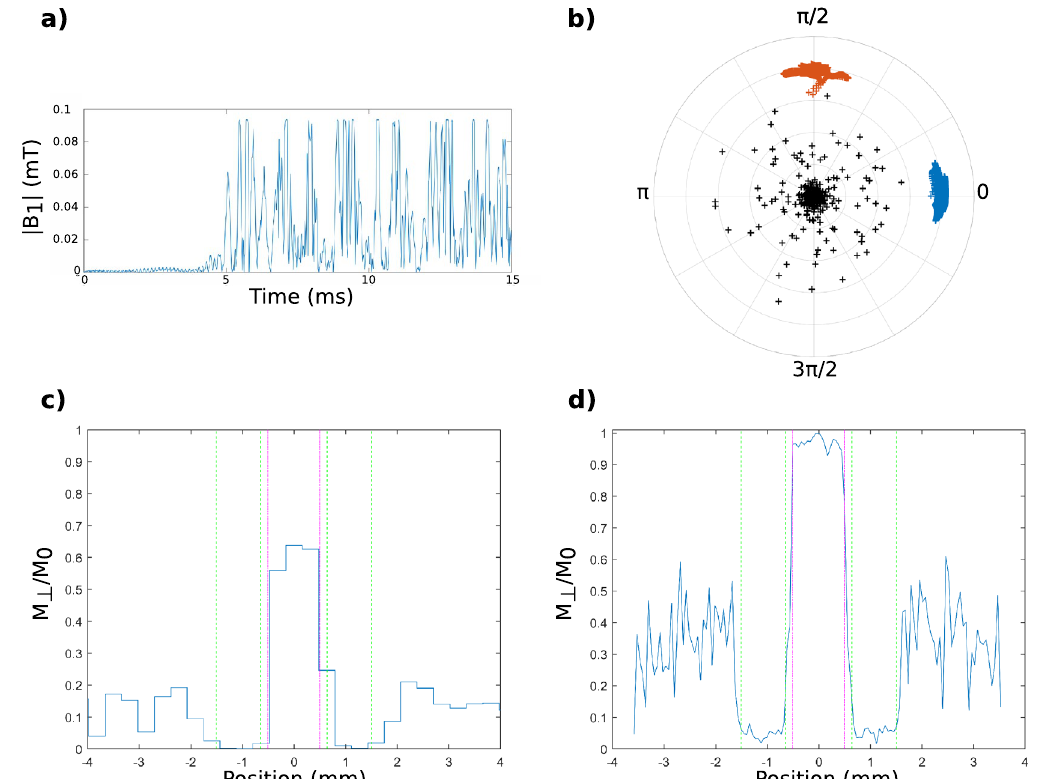
Figure 3. ( a ) Temporal evolution of the magnitude of the OC RF pulse A ( B 1 = u x ). ( b ) Final transverse magnetization states in the Bloch sphere after the application of the OC pulse. The null (blue) and π/2 (orange) phase isochromats are perfectly distinct. ( c ) Simulated slice profile ( d ) experimental slice profile obtained with a RF profile sequence. The same resolution parameters were used in the simulation and experimental RF profile. The pink and green dashed lines in ( c ) and ( d ) represent the theoretical controlled slice thickness and outbands,